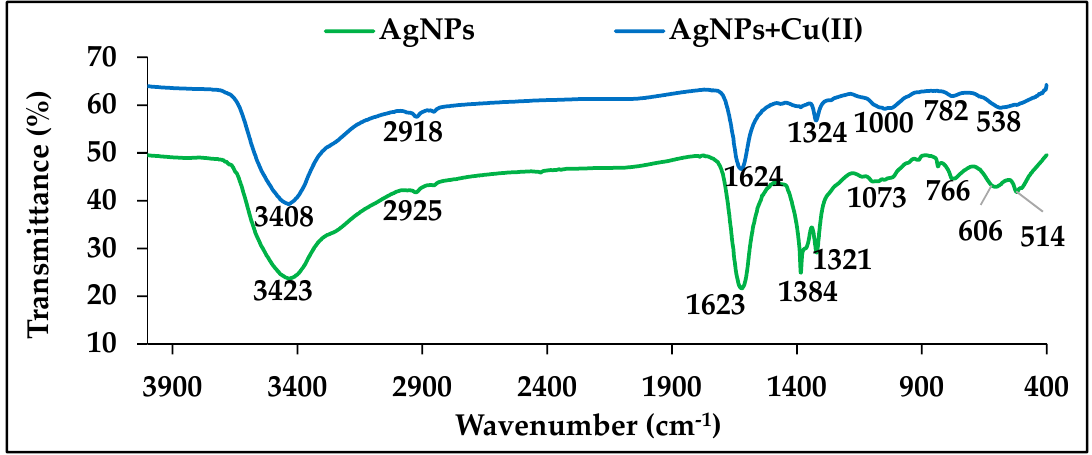
Figure 3. A Fourier-transform infrared spectroscopy (FTIR) analysis of the functional groups in AgNPs before and after Cu 2+ was adsorbed.